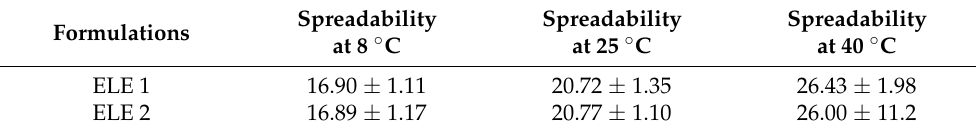
Table 3. Average spreadability values of ELE 1 and ELE 2 kept at the indicated temperature.